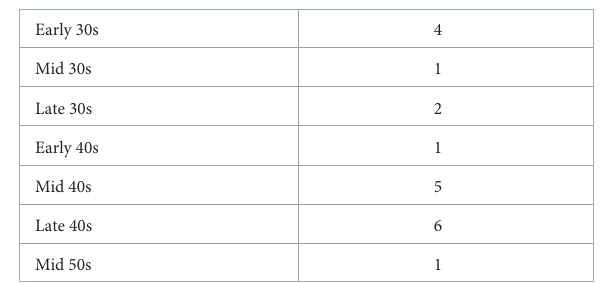
TABLE 3 Parental age groups.